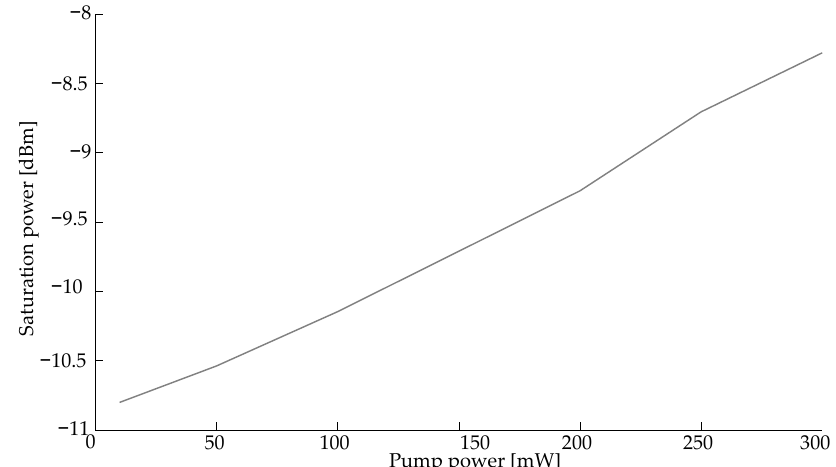
Figure 13. Measurement scheme with a Raman amplifier.